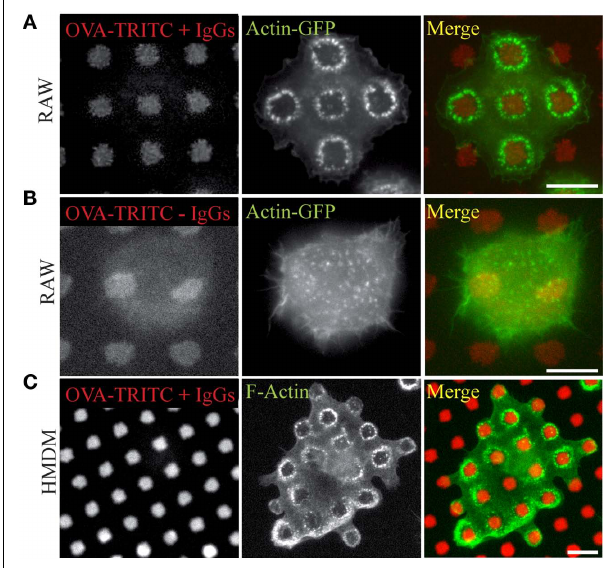
FIGURE 2 | Frustrated phagocytosis of macrophages on micro-texturized surfaces. Micro-patterns of OVA-TRITC were laid on glass cover slips as in Figure 1 , and then incubated (A,C) or not (B) with anti-OVA antibodies. RAW–GFP (A,B) or hMDMs (C) were layered on the substrata for 15min, then fixed and stained (C) with phalloidin-FITC and imaged. OVA-TRITC and actin-GFP (A,B) . Bars = 5 μ